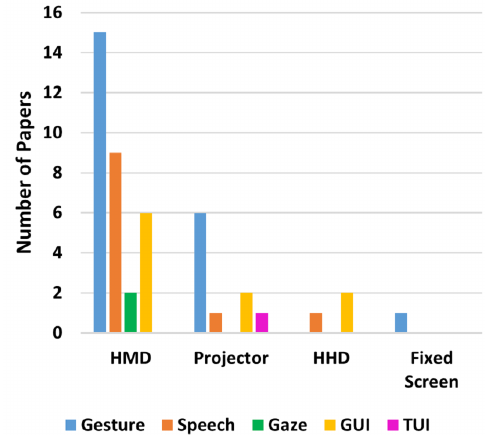
Figure 18. User interaction modalities by visualization